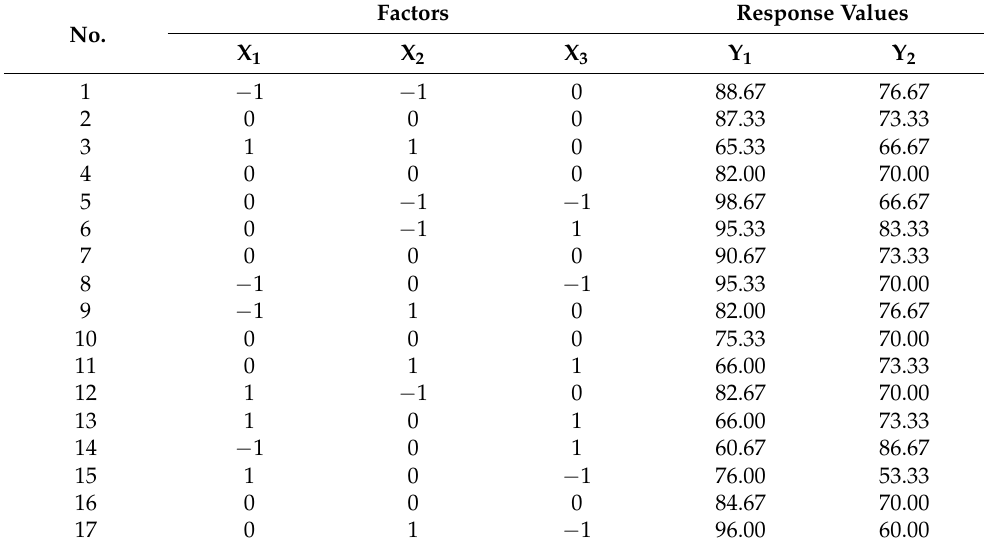
Table 3. Results of the stem transport-position adjustment mechanism bench test. Factors Response No.